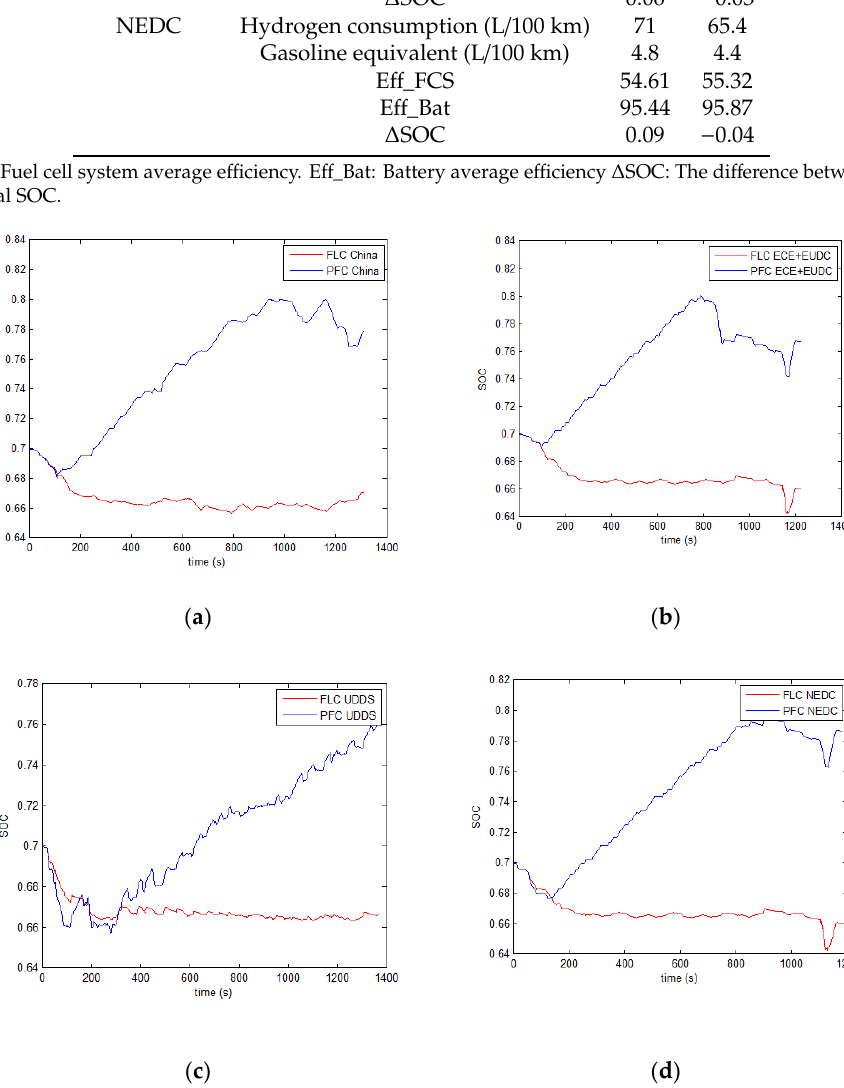
Figure 4. SOC in di ff erent driving cycles. ( a ) Chinese Typical City Driving Cycle (China), ( b ) Economic Commission for Europe and Extra Urban Driving Cycle (ECE + EUDC), ( c ) Urban Dynamometer Driving Schedule (UDDS), and ( d ) New Europe Driving Cycle